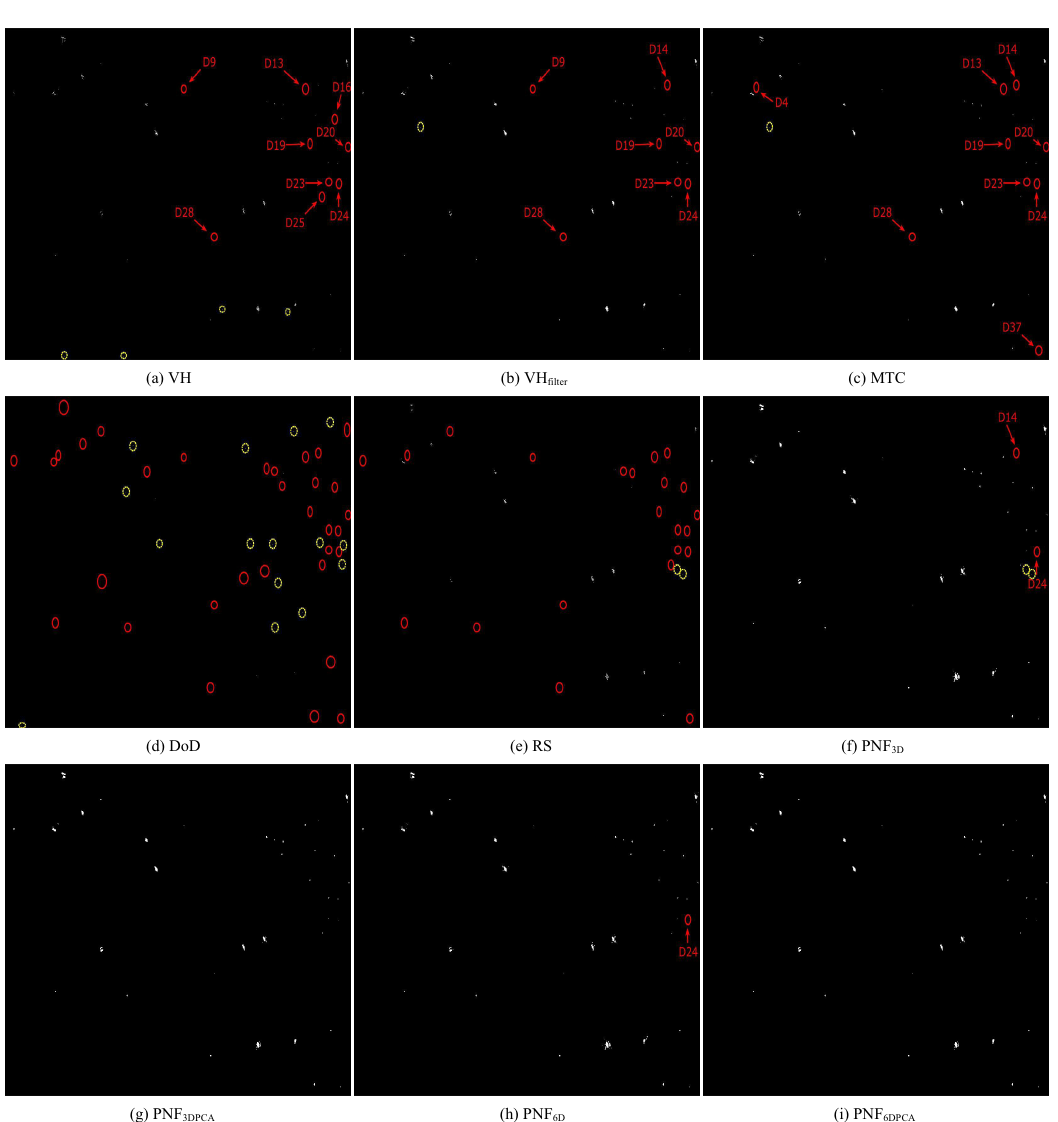
Figure 13. Ship detection results of different methods on D. ( a ) VH; ( b ) VH filter ; ( c ) MTC; ( d ) DoD; ( e ) RS; ( f ) PNF 3D ; ( g ) PNF 3DPCA ; ( h ) PNF 6D ; ( i ) PNF 6DPCA . Red circles indicate missing ships. Yellow dashed circles mean false